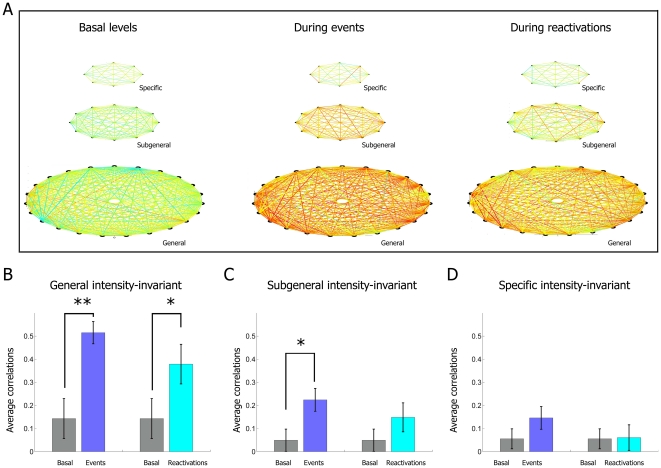
Cross-correlation analysis of various feature-encoding units
belonging to the intensity-invariant subpopulation.(A) Correlations between top representative CA1 invariant
units from data set #1 encoding a specific type of events (top row),
subgeneral feature (two or more types of events, second row), and
general feature (response to all four types of events, third row), are
displayed as colored lines during basal activity periods (first column),
the actual event periods (second column) and at the time of
reactivations (third column). (B) In contrast to the
intensity-sensitive results, significant average correlations are
maintained during the reactivation period for the general
intensity-invariant subgroups. These trends are maintained, although to
a smaller degree, for the Subgeneral intensity-invariant population
(C), and are not statistically different for the
specific intensity-invariant subpopulations, although the very small
sample size makes it impossible to draw any strong conclusion from this
particular case (D).